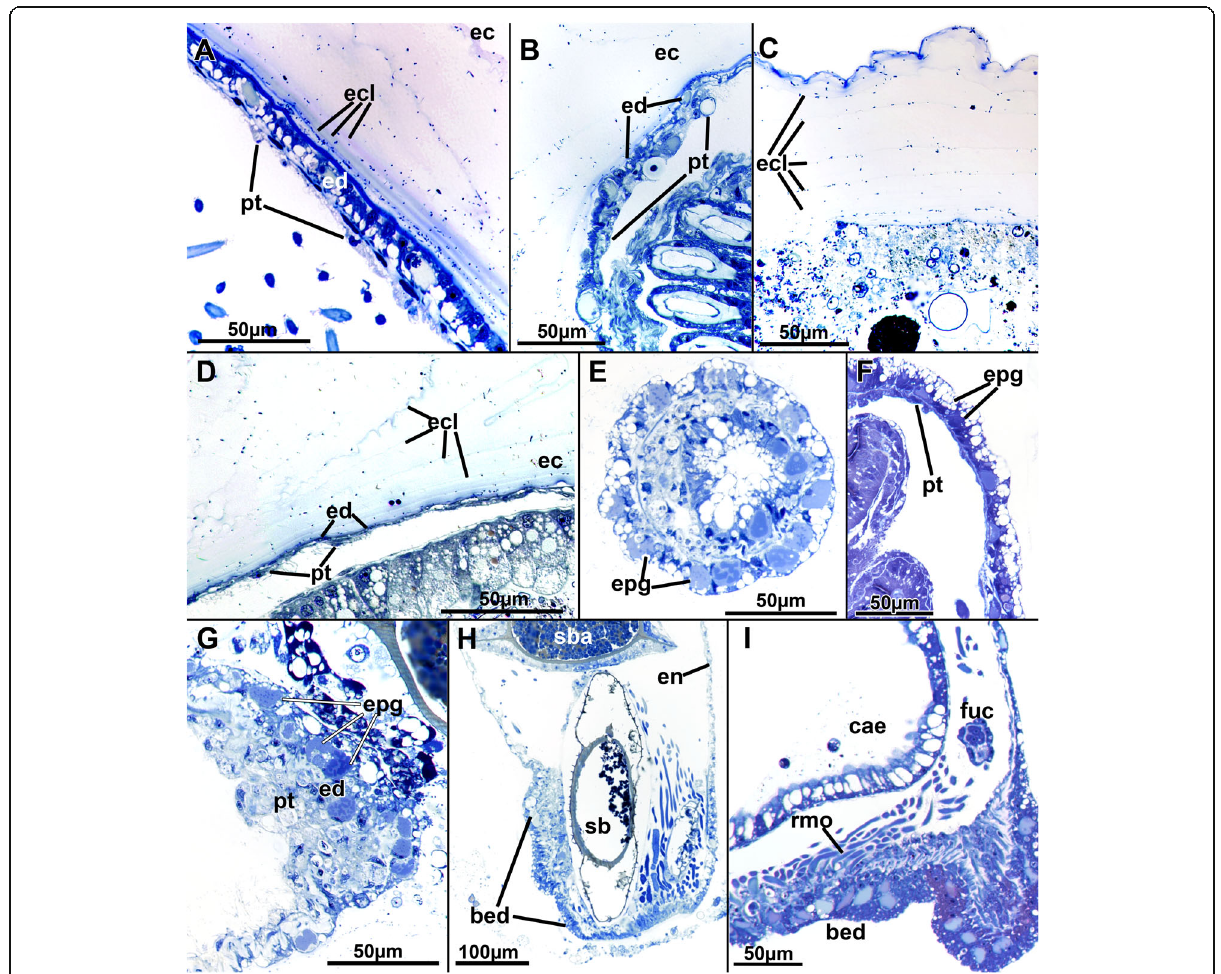
Fig. 2 Histological details of the cystid wall of Stephanella hina . Semithin sections. a-d The ectocyst secretion consists of various concentric layers as seen by their granular stained borders. a Close to the endocyst, several distinct thin layers are discernible. The epidermis is prominent, while the peritoneum is not. b Body wall with thin epidermis and thicker, prominent peritoneum. c Distinct layers of the ectocyst are visible. The ectocyst stains only weakly, but its uppermost layer (top of image) is often more conspicuous. d Endocyst with extremely thin epidermis and peritoneum. e-g Epidermal glandular parts of the body wall. e Section of numerous translucent vesicles and other more distinctly stained vesicles. f Similar to E, longitudinal section. g Endocyst with a prominent peritoneal layer, probably containing lytic tissues and substance. h Longitudinal section of a zooid showing prominent glandular epidermis at the basal side (bottom of image) where the animal is attached to the substrate and the anchorage of the prominent retractor muscle fibres is located. i Detail of the basal epidermal attachment pad showing a high abundance of glandular vesicles. Abbreviations: bed - basal epidermis, cae - caecum, ec - ectocyst, ecl - ectocyst layers, en - endocyst, ed. - epidermis, epg - epidermal glands, fuc - funiculus, pt. - peritoneum, rmo - retractor muscle origin, sb - statoblast, sba - statoblast